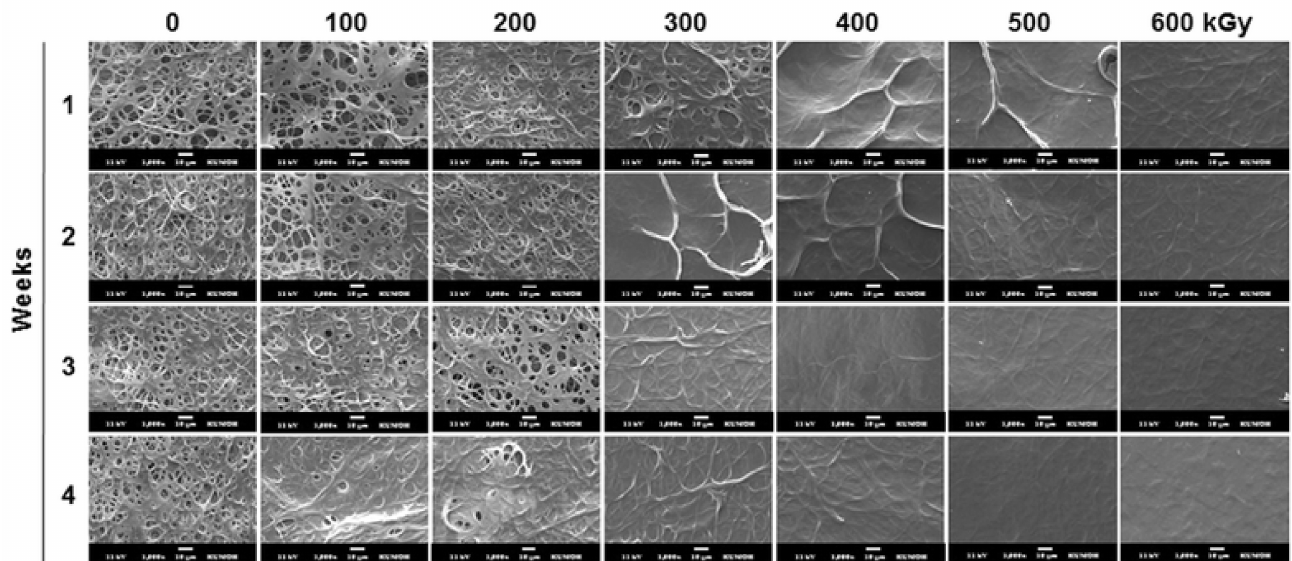
Figure 3. Morphology of e-beam crosslinked gelatin nanofiber mats as a function of irradiation dose and incubation period at T = 37 ◦ C in PBS. Scale bars are 10 µ m. Reprinted from [48], originally published under a CC-BY